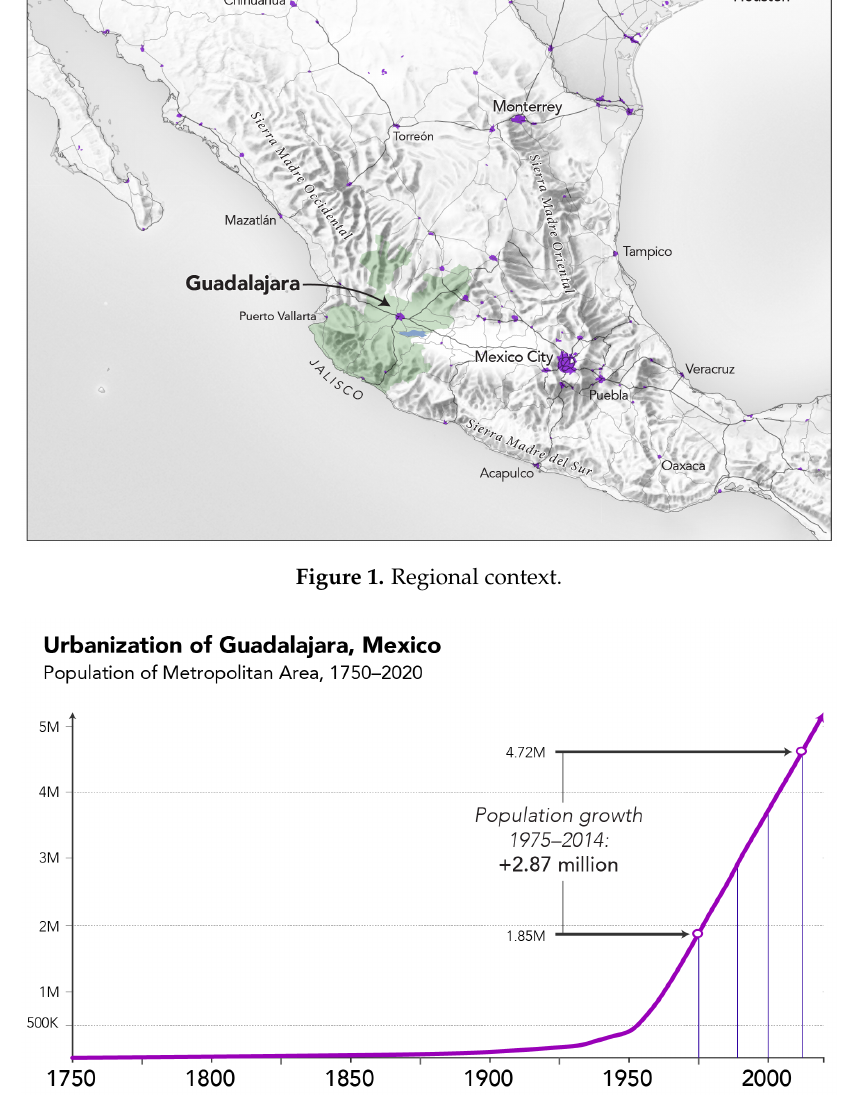
Figure 2. Population growth in